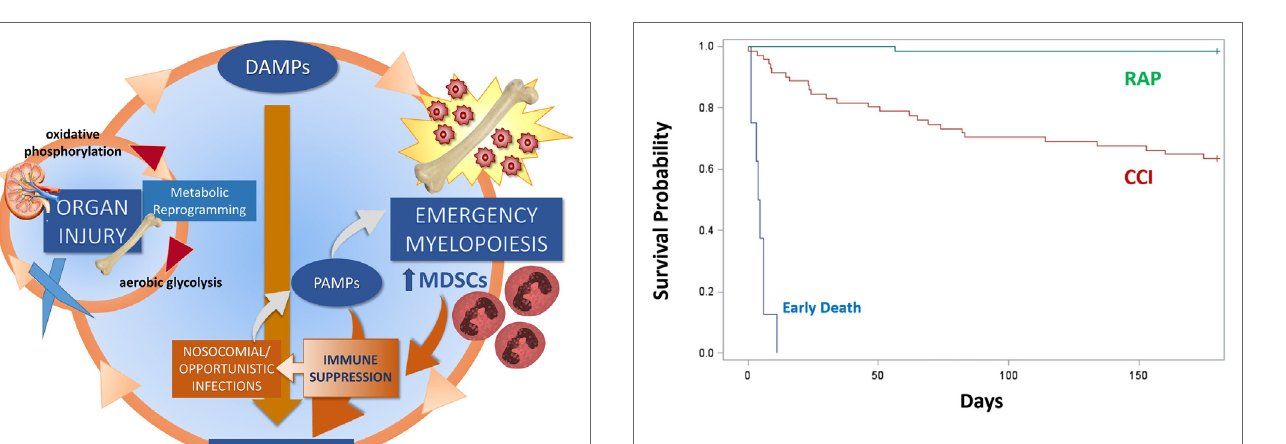
FigURe 3 | Survival of CCI ( n = 71) or RAP ( n = 66) patients 6 months after sepsis. Trajectories were classified as early death (blue), RAP (green), and CCI (red). Kaplan–Meier analysis demonstrated significant differences ( p < 0.01) in survival between groups. Abbreviations: CCI, chronic critical illness; RAP, rapid